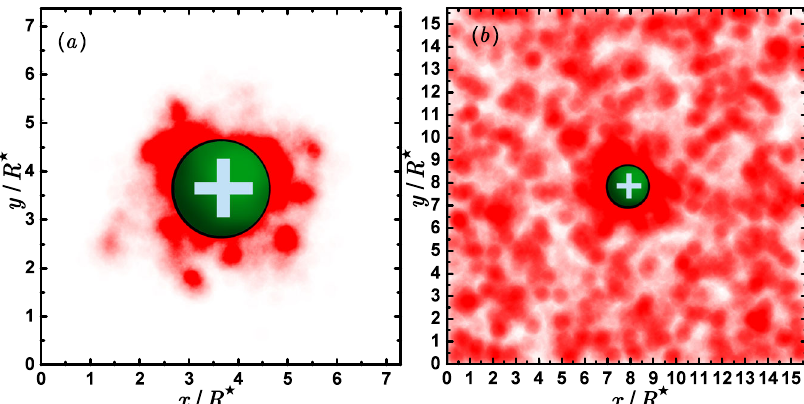
Fig. 3 Snapshots of instantaneous particle positions in numerical simulations. Particle coordinates are represented for two characteristic numbers of bosons: a N = 50 particles b N = 500 particles. Note that in the critical number of atoms which can be trapped by the ion, N c = 140, is ( a ) larger ( b ) smaller than the number of particles N , correspondingly. Parameters of the interaction are chosen such that the value of the atom-ion s -wave scattering length equals to the characteristic length-scale R ⋆ of the C 4 decay (1), a ai = R ⋆ . The red areas denote instantaneous positions of the bosons in the box potential. Coordinates are shifted so that the ion appears in the